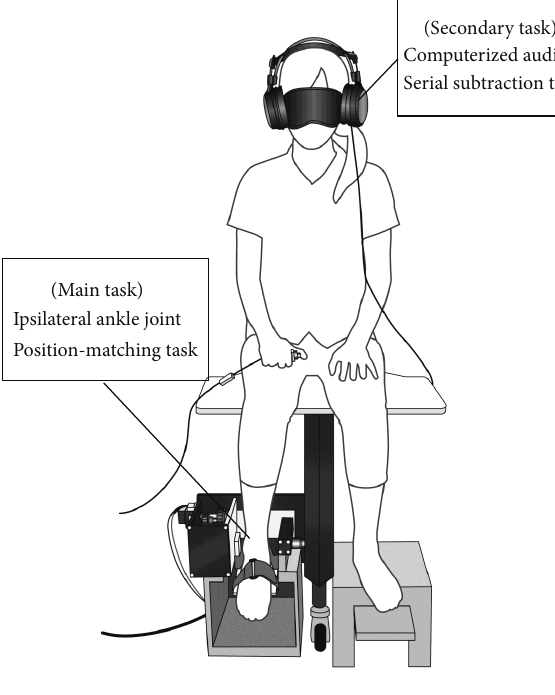
Figure 1: Experimental setup.